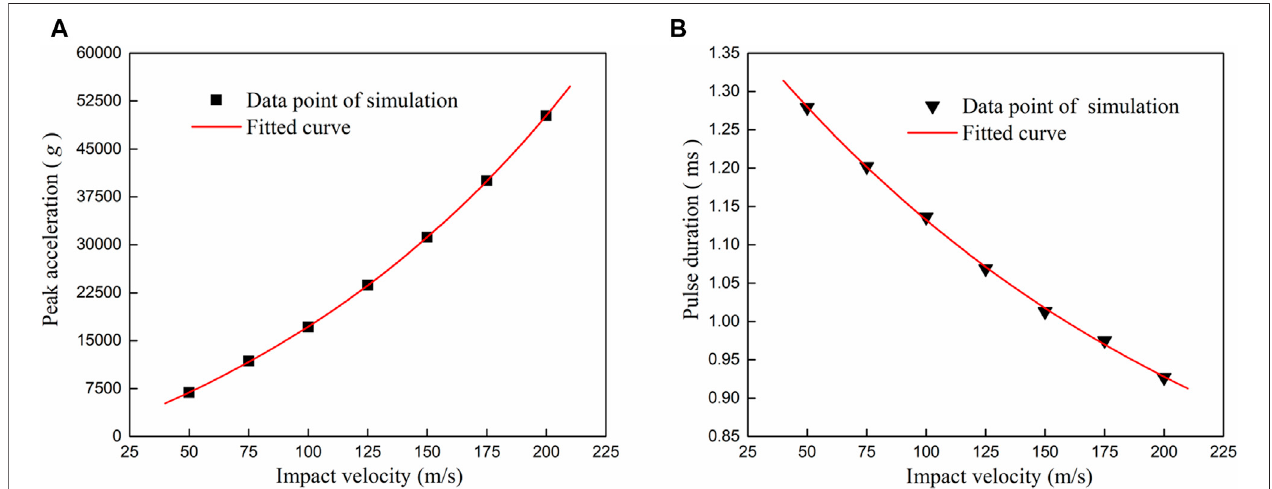
FIGURE 6 | (A) Variations in the peak acceleration and (B) the pulse duration with the velocity.